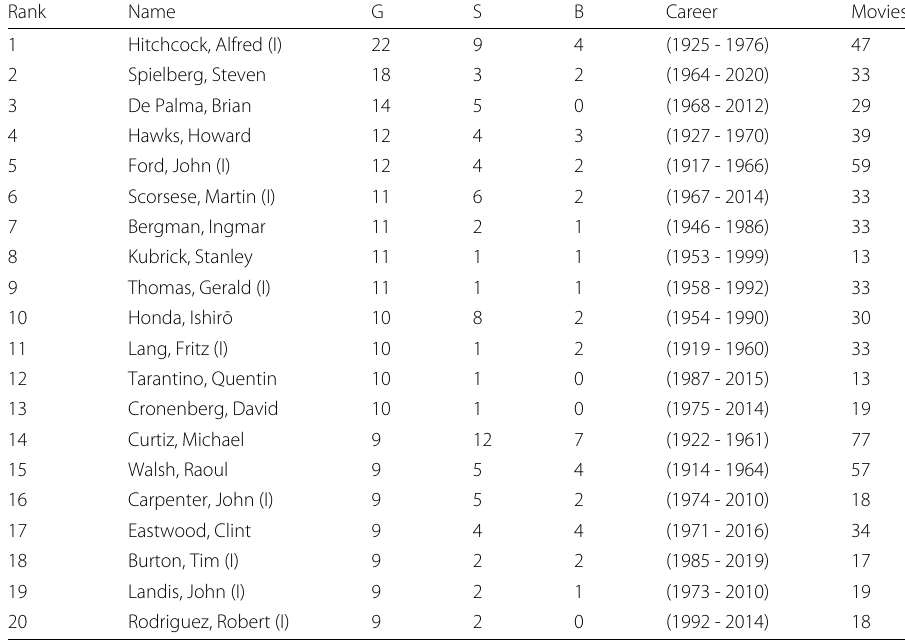
Table 4 Top 20 directors: each item contains the number of golden (G), silver (S) and Bronze (B) points collected, the year of the first and last movies, and the number of films directed in